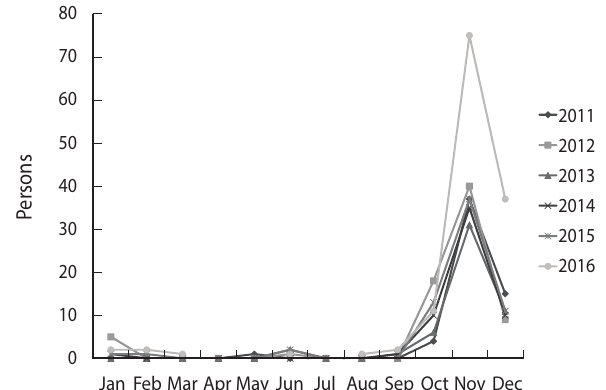
Jan Feb Mar Apr May Jun Jul Aug Sep Oct Nov Figure 2. Monthly trend of scrub typhus. The incidence peaked in November.